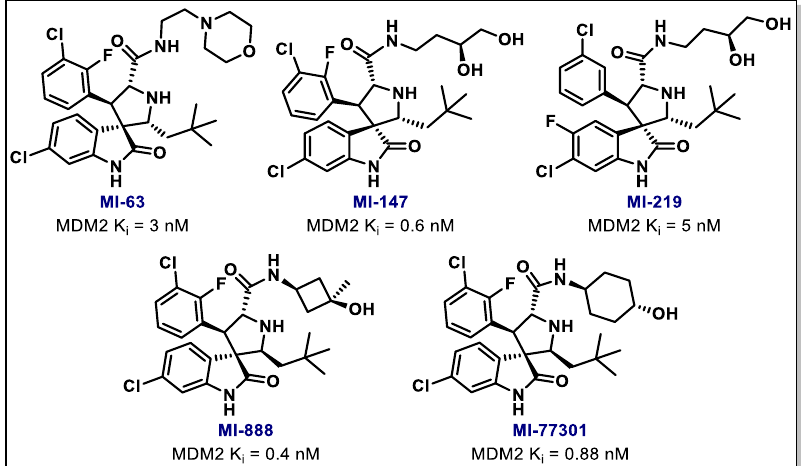
Figure 5. Series of compounds containing the spiropyrrolidone scaffold that showed high activity to restore p53 via MDM2 inhibition.